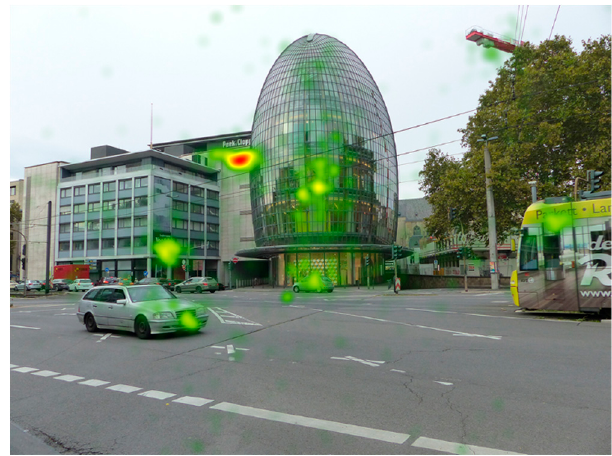
Figure 7. Visualisation of results in the form of a heat map for all subjects for image 2.